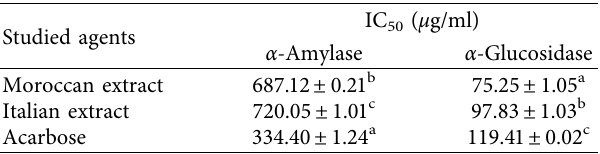
Table 4: Digestive enzyme inhibition activity ( α -glucosidase and α -amylase) of C. sativus aqueous